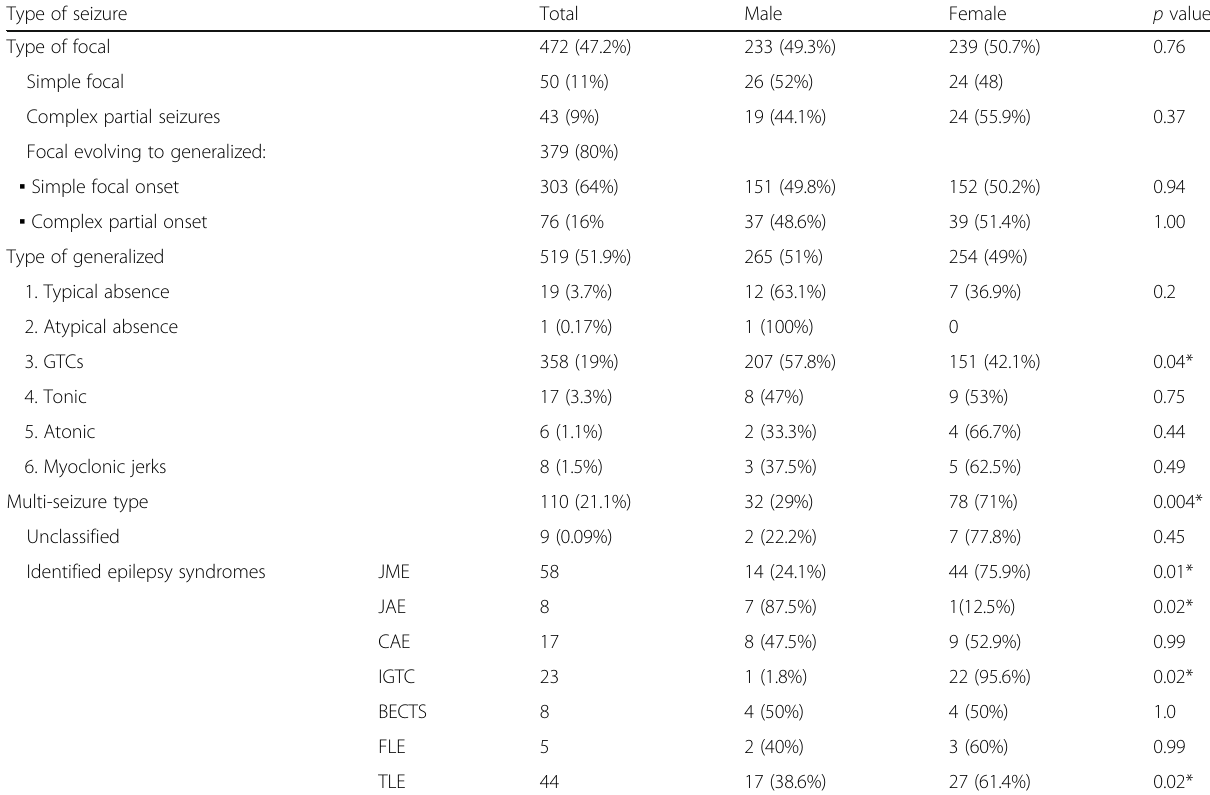
Table 2 Clinical data